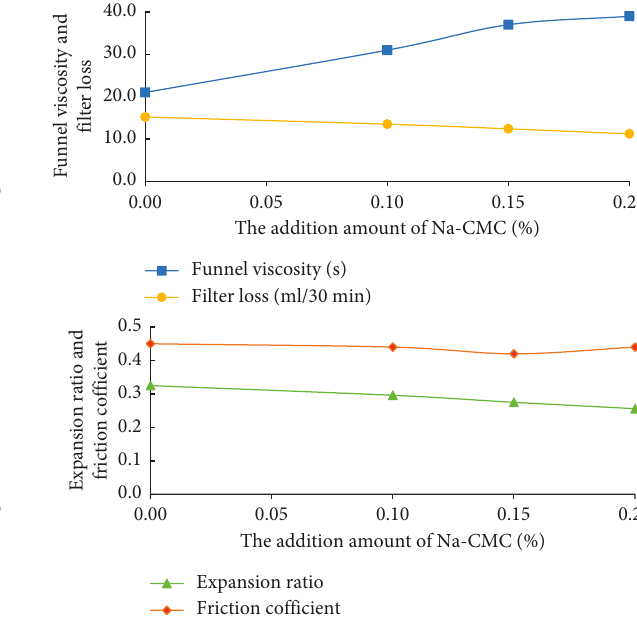
Figure 2: The effect of plant glue on the slurry properties.